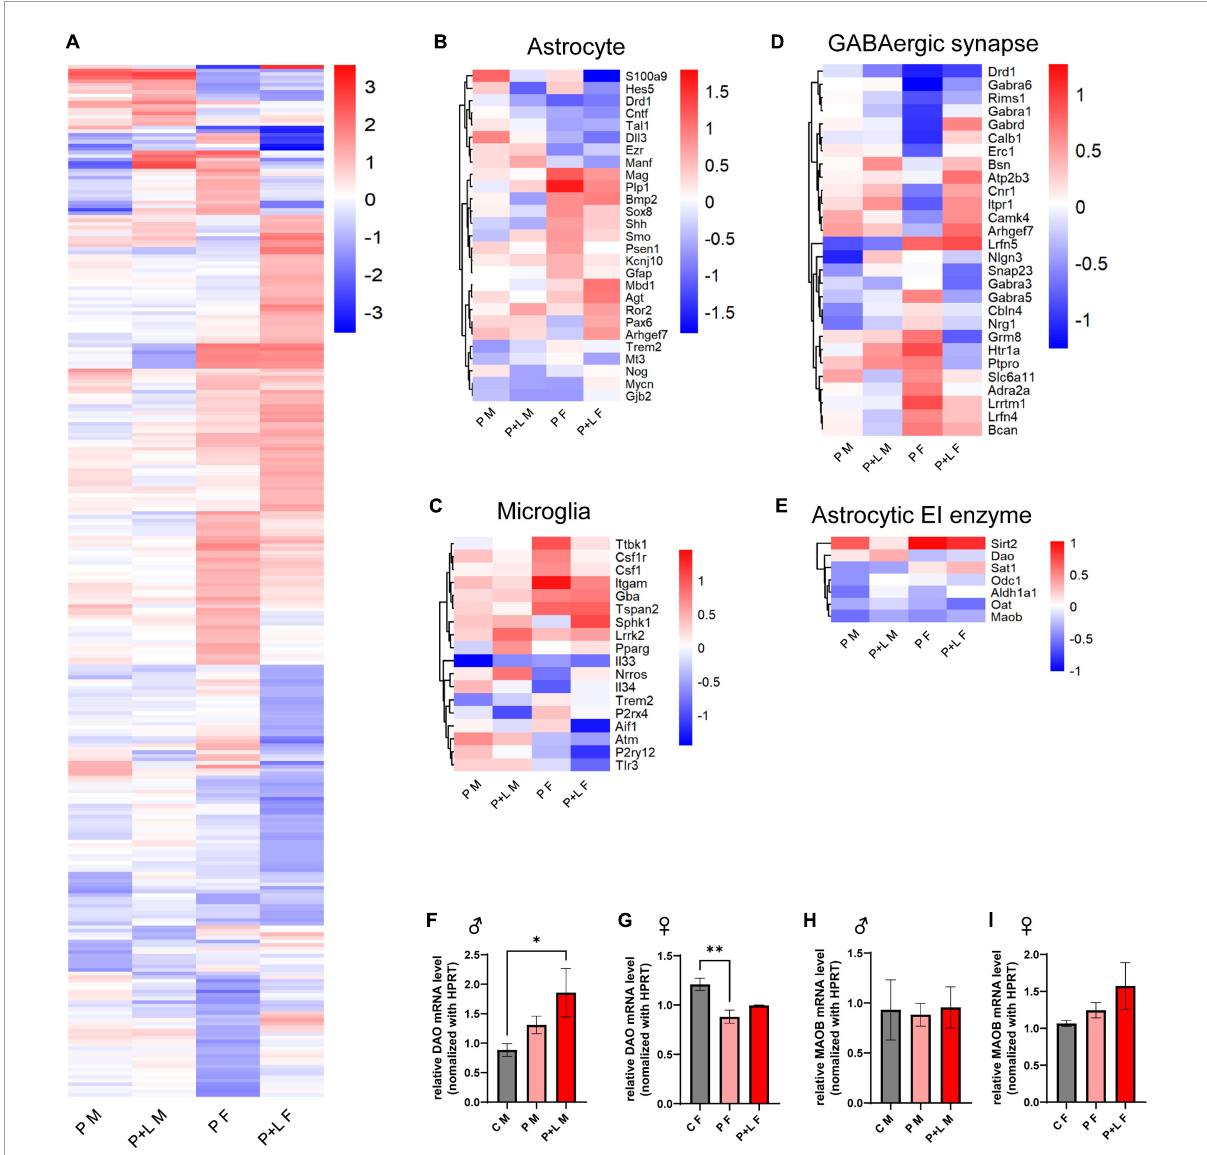
FIGURE5 GABA associated gene expression were altered by maternal lead exposure. (A) Whole gene heatmap. N = l. (B–E) Hierarchical clustering heatmap of genes related to (B) astrocyte function, (C) microglia function, (D) GABA synapse, (E) GABA producing cycle related enzyme. (F,G) Statistical analysis of relative Dao mRNA level change in offspring cerebellum. N = 3 (male), 4 (female). Expression levels were normalized to Hprt . Data were analyzed with one-way ANOVA and expressed as mean ± SEM. ∗ p < 0.05, ∗∗ p < 0.01. (H–I) relative Maob mRNA level change in offspring cerebellum. N = 3 (male), 3 (female). mRNA expression levels were normalized to Hprt . Data were analyzed with one-way ANOVA and expressed as mean ±